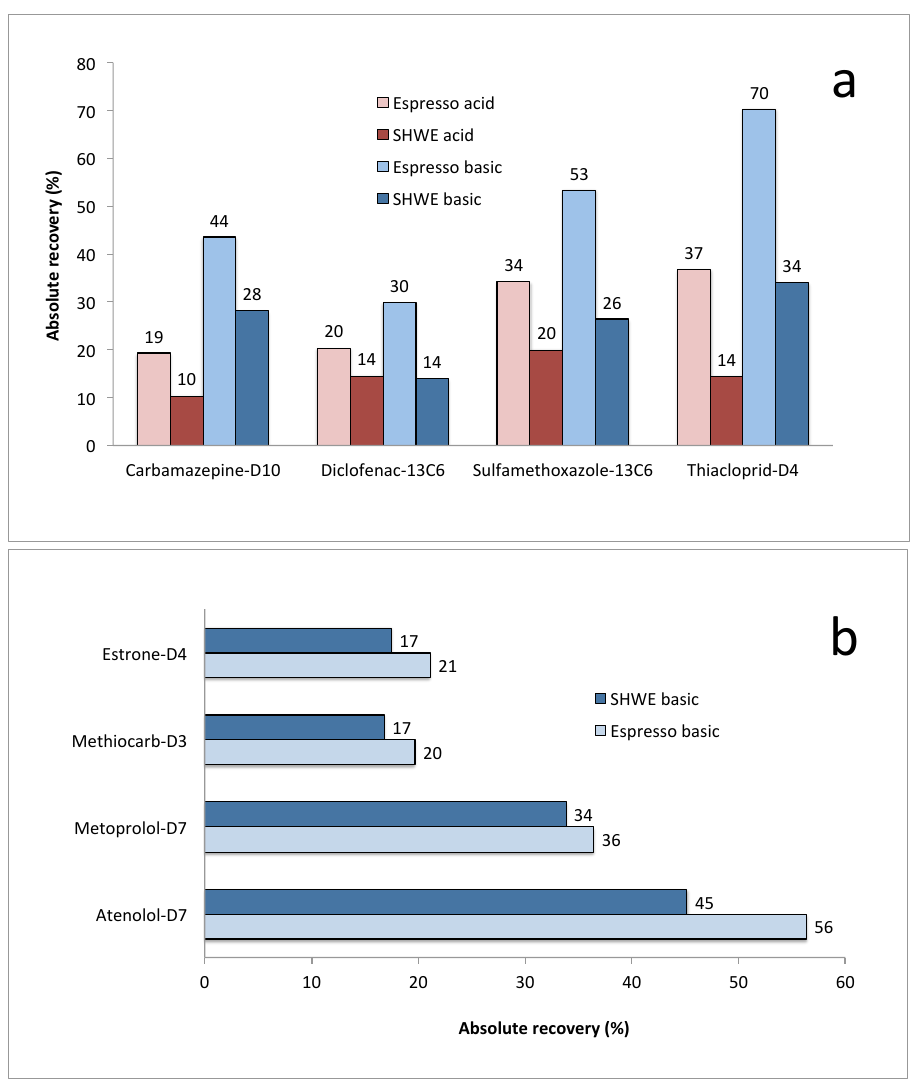
Figure 3. Absolute recovery for eight labelled standards spiked at the top of the extraction cell, containing the sewage sludge, and the instrumental standard thiacloprid-d4 spiked just prior to the analysis. The absolute recovery was calculated using Equation (1). Four analytes were analysed using two di ff erent chromatographic methods at acid and basic conditions ( a ), while four of the compounds could only be analysed at basic conditions ( b